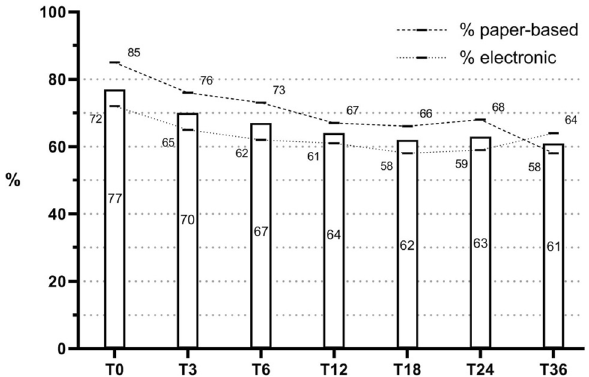
Figure 4. Completion rates of questionnaires until three years after enrollment. Overall completion rates are presented in the bars, and electronic and paper-based percentages at the dashed lines. Time-points (T) are months since